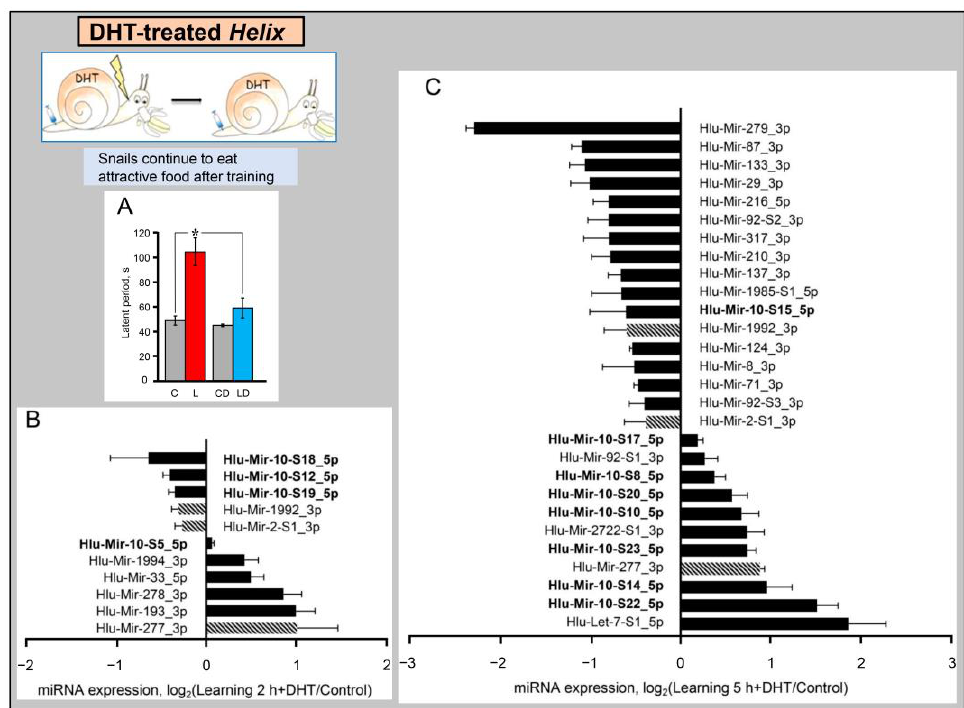
Figure 5. Training regulates miRNA expression in the CNS of DHT-treated Helix . ( A ) The pretreatment by the neurotoxin 5,7-DHT interferes formation of the food aversion reflex in Helix. The ordinate is the latent period of the consummatory responses of animals. Designations: C and CD -animals before training, normal ( n = 12), and DHT-treated ( n = 8), correspondingly; L and LD -trained animals, normal ( n = 12) and DHT-treated ( n = 8), correspondingly. Repeated measures ANOVA [Treatment (Normal, DHT-treated) x Training (Before, 3 days after)] with repeated measures in the factor “Training” showed a significant interaction between the factors, F (1, 18) = 5.0, p = 0.039. * p < 0.05. ( B , C ) -Relative RNA expression 2 h ( B ) and 5 h ( C ) after training was assessed using next-generation sequencing normalizing first to the total number of miRNA reads in each sample and then to the mean expression value in control groups of naive animals. The hatched columns indicate miRNAs, which show similar dynamics 2 and 5 h after training. Statistical significance was assessed using the U-test ( p < 0.05). The error bars represent the standard error of the mean. The number of samples in experimental groups is as follows: Control, n = 10; 2 h post-training, DHT-treated, n = 6; 5 h post-training, DHT-treated, n = 3.